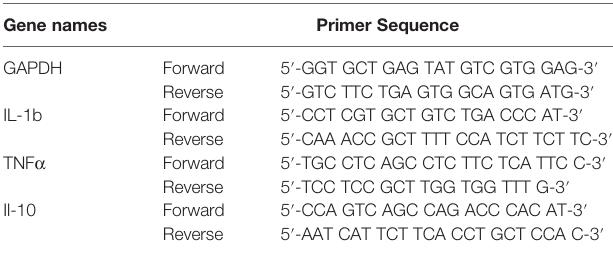
TABLE 1 | Sequences of the primers used for real-time